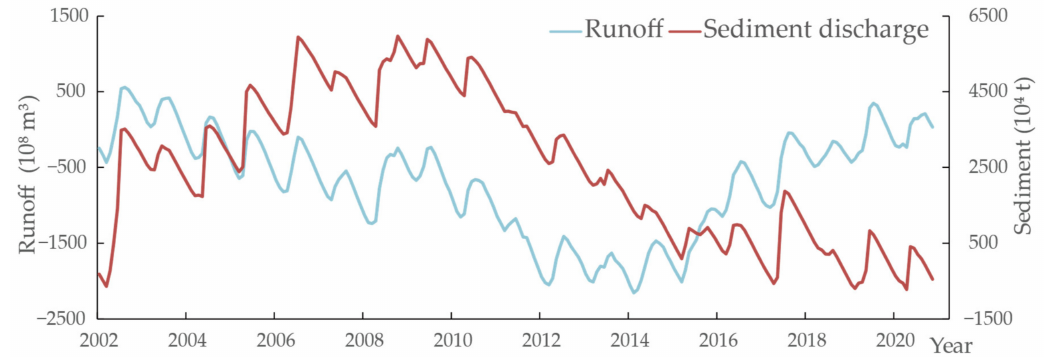
Figure 14. Cumulative departure analysis of runoff and sediment load at Gaoyao station, the outlet of the West